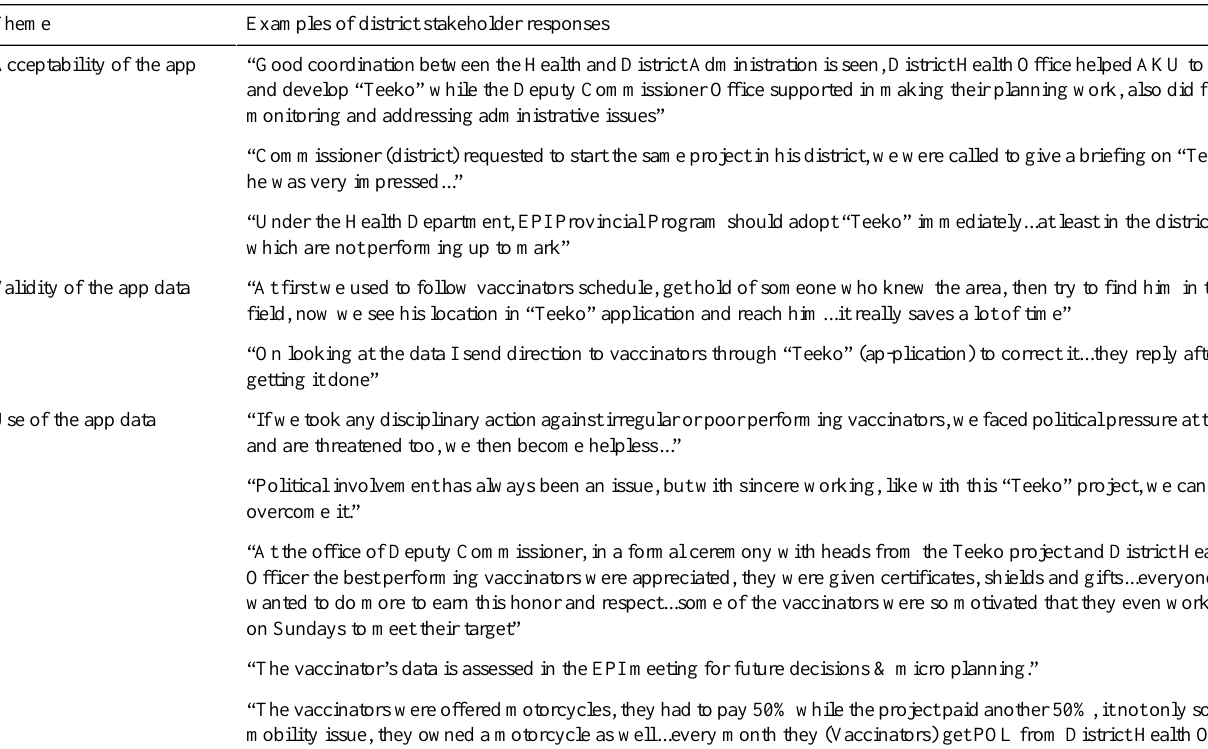
Table 4. Specific responses from the district stakeholder interviews, organized by theme. Examples of district stakeholder